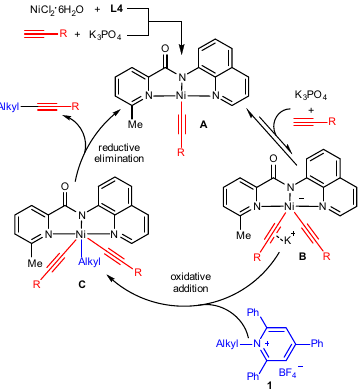
Fig. 7 Proposed reaction mechanism for the nickel-catalyzed deaminative Sonogashira coupling of alkylpyridinium salts. A plausible mechanism involving a more electron-rich Ni bis(acetylide) species is tentatively General procedure 2 . In a nitrogen- fi lled glovebox, NiCl 2 ·6H 2 O (0.03 mmol, 7.1 mg), L4 (0.03 mmol, 7.9mg), anhydrous K 3 PO 4 (0.39 mmol, 82.8mg), secondary alkylpyridinium salt (0.3mmol), and N,N -dimethylformamide (1.5 mL) were suc- cessively added to an oven-dried sealable Schlenk tube (10.0 mL) followed by addition of phenylacetylene (0.45 mmol, 46.0 mg) via microliter syringe. Then the